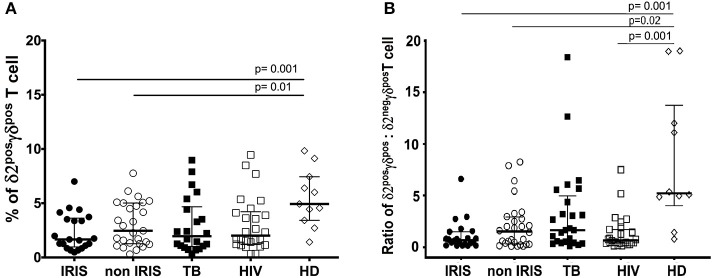
δ2posγδposT cells and the ratio of δ2posγδpos: δ2negγδposT cell in TB-IRIS, and non-IRIS at baseline. The proportion of δ2posγδpos T cell (A), the ratio of δ2posγδpos: δ2negγδpos T cell (B) in TB-IRIS, non-IRIS, and control groups: [TB (TB+/HIV–), HIV (HIV+/TB–), HD (HIV–/TB–)] are shown. Results are expressed as median and 25–75% interquartile range. Significant p-values (p < 0.05) are indicated.